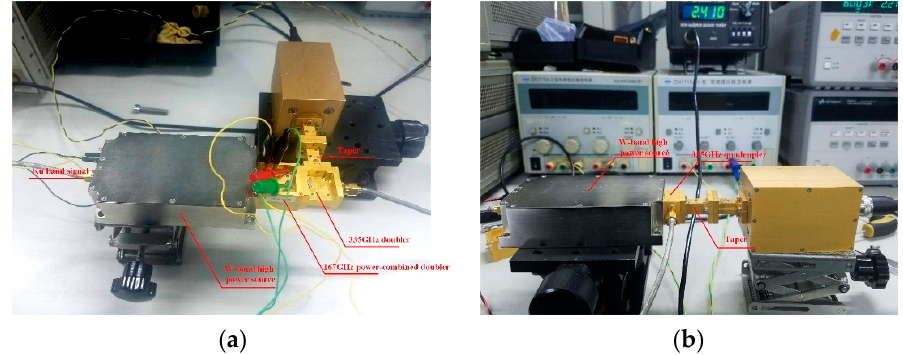
Figure 8. ( a ) Photo of the assembled 335 GHz source with two cascaded doublers. ( b ) Photo of the assembled 335 GHz source with a single-stage quadrupler.